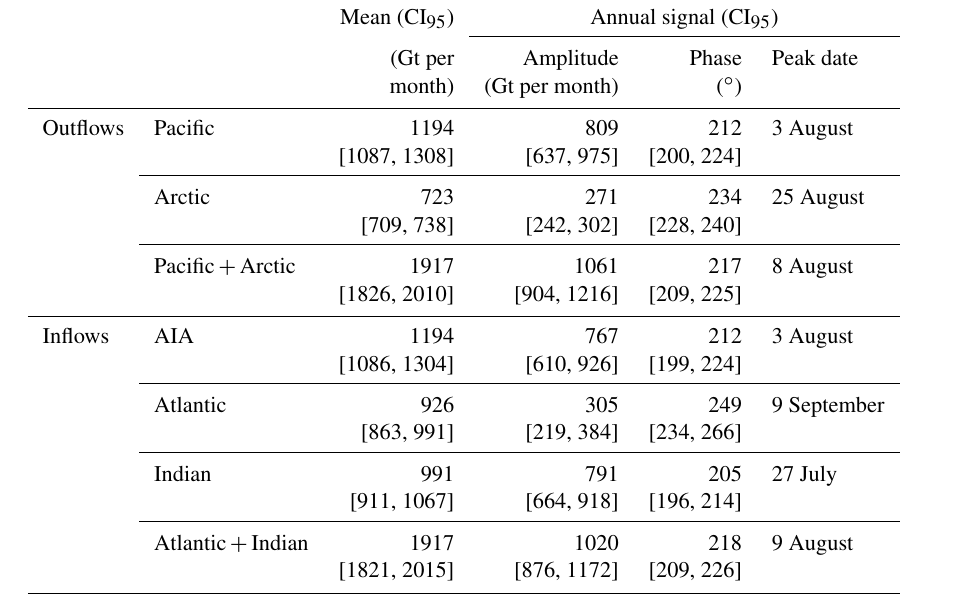
Table 1. Mean and annual signals of the N component as estimated from the CSR mascon solution for different ocean basins according to Eq.